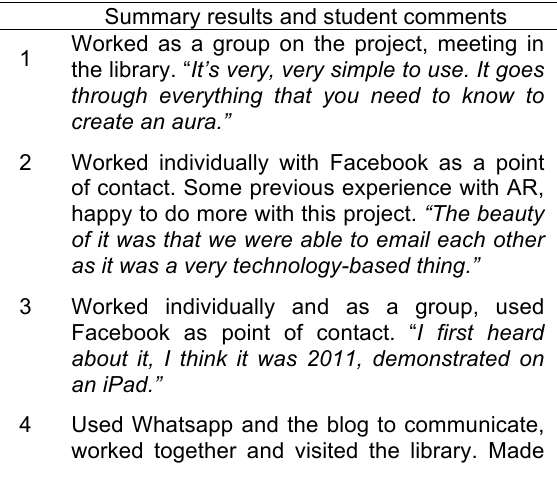
Table 1. Key results from group interviews Summary results and student